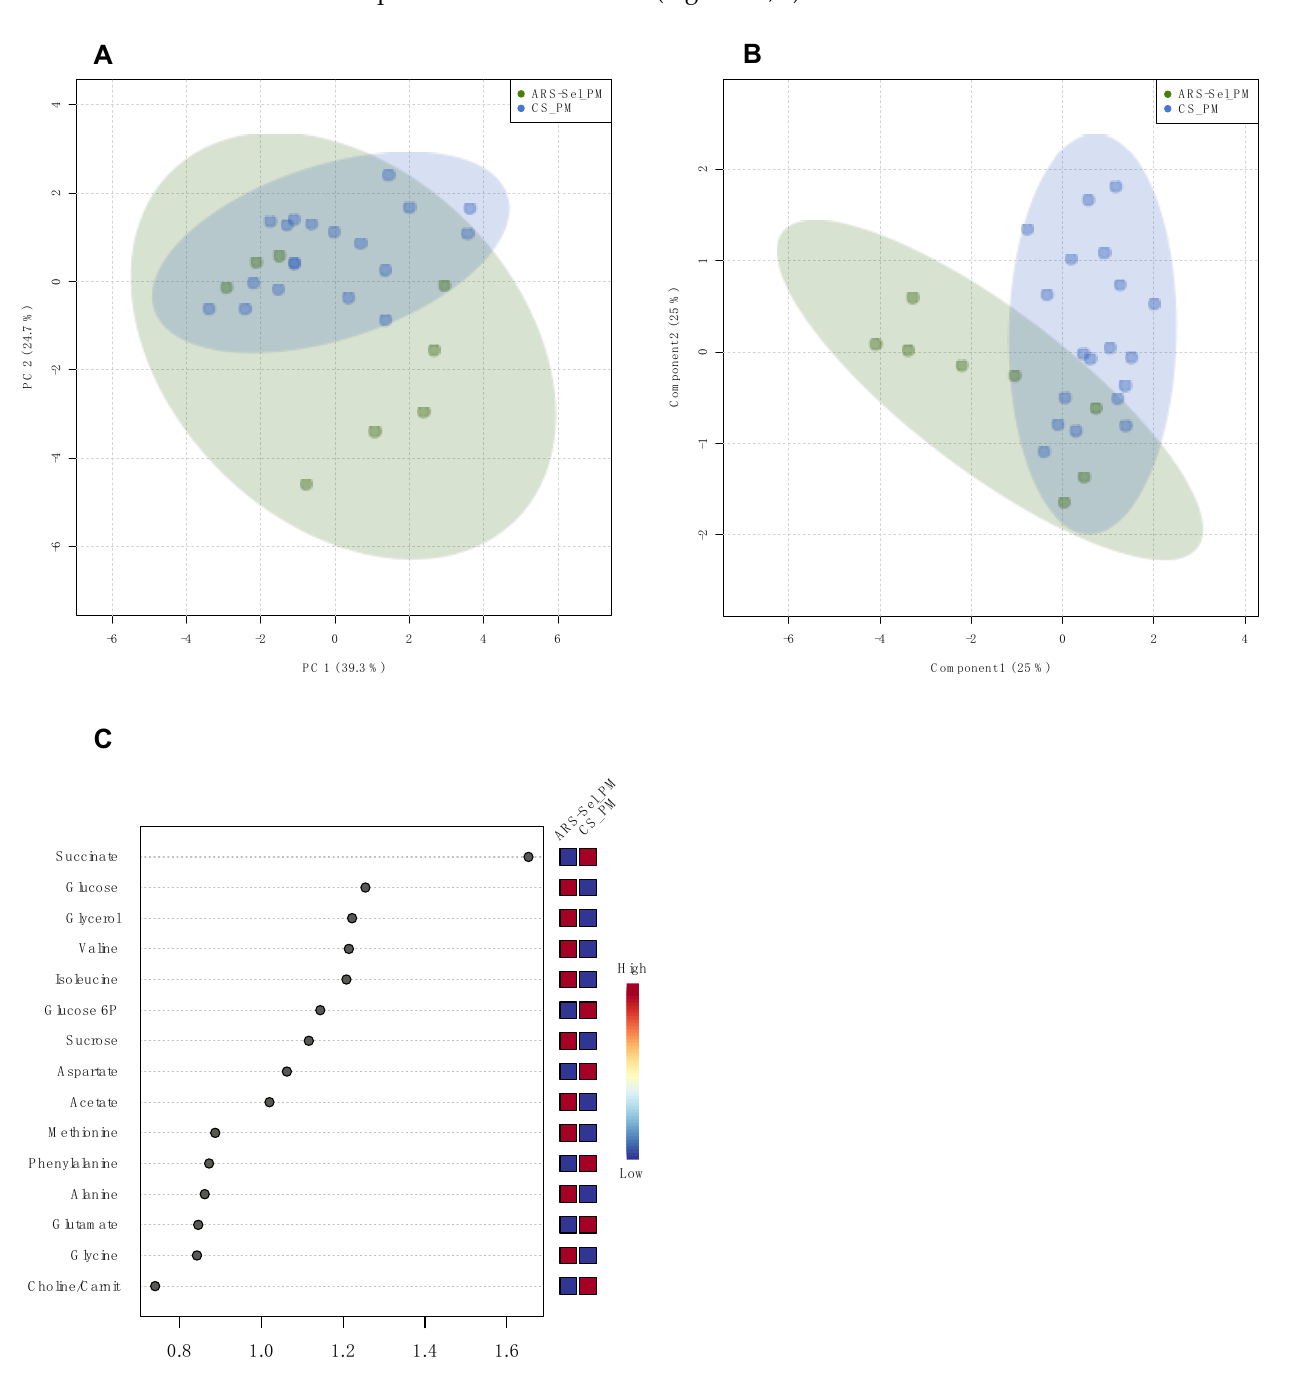
Figure 4. Multivariate analysis of groups ARS- Sel _PM and CS_PM in digesta: ( A ) PCA scores plot; ( B ) PLS scores plot, model validated (NC = 1; R 2 = 0.445; Q 2 = 0.176; 1000 permutations: p = 0.042); ( C ) VIP of the PLS scores plot model.